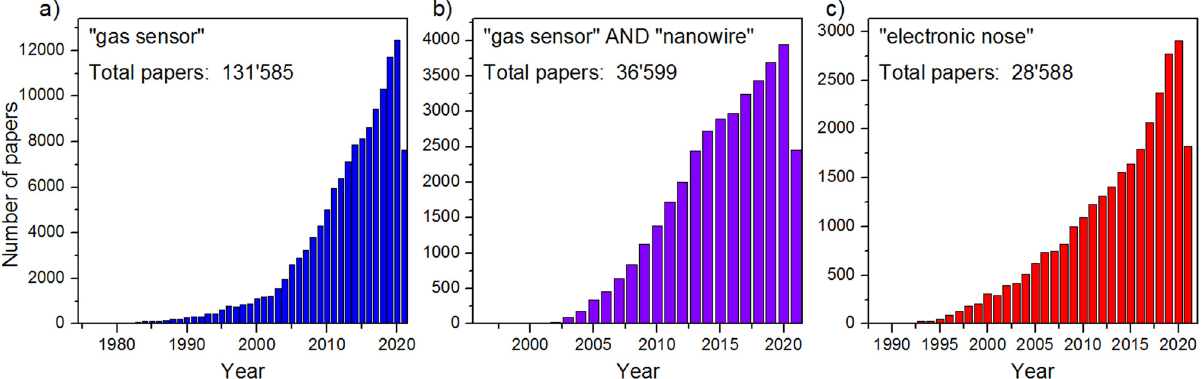
Figure 1: Trend in the number of scienti fi c articles per year found searching for ( a ) “ gas sensor ” , ( b ) “ gas sensor AND nanowire ” , and ( c ) “ electronic nose ” on Scopus [ 1 ]